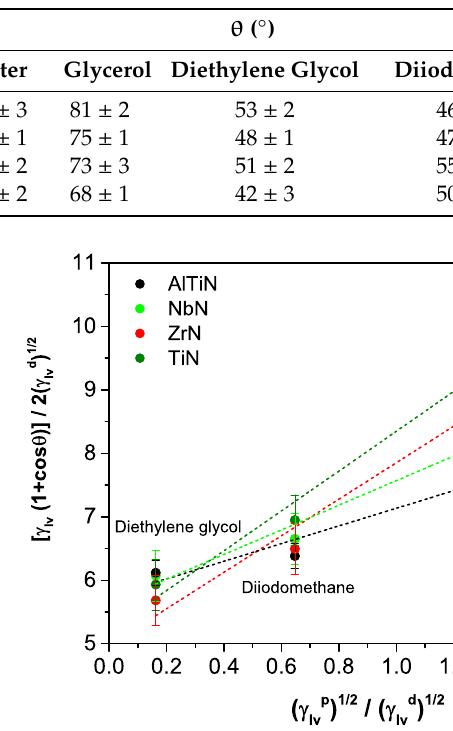
Figure 2. Surface Free Energy by Owens Wendt Rabel Kaeble (OWRK) elaboration for all the investigated coatings.